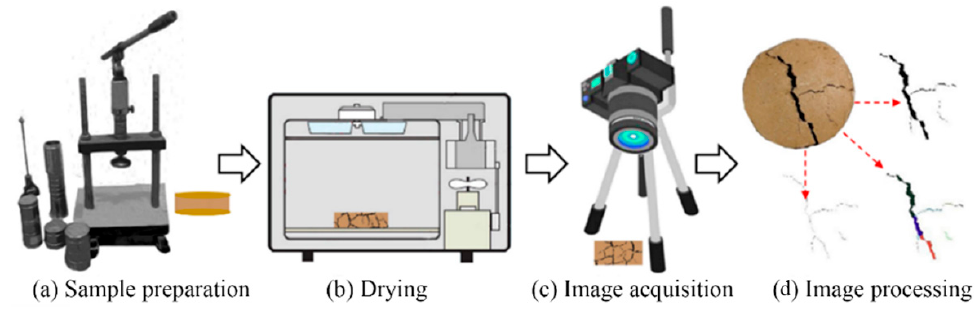
Figure 12. The schematic diagram of the test process: ( a ) sample preparation; ( b ) drying; ( c ) image acquisition; ( d ) image processing.